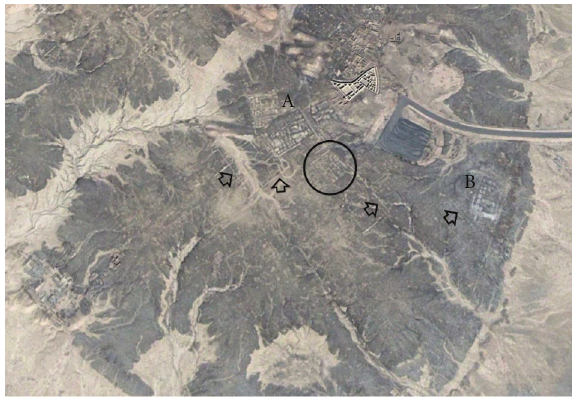
Figure 11: Traces of structures and streets between the Neo- Babylonian Houses (A) and the Enki Temple (B) in a pan-sharpened QuickBird-2 image of February 2002 (colour composite RGB bands 3-2-1): the arrows indicate buried streets and walls along their sides, while the circle highlights buried structures (maybe other Neo- Babylonian